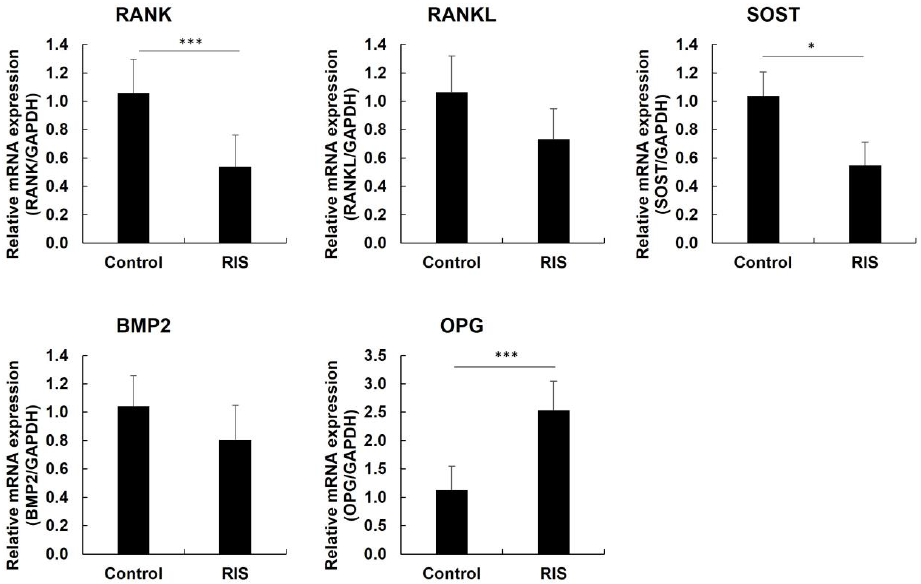
Figure 4. PCR results of RANK, RANKL, SOST, BMP2, and OPG (* p < 0.05, *** p < 0.005).